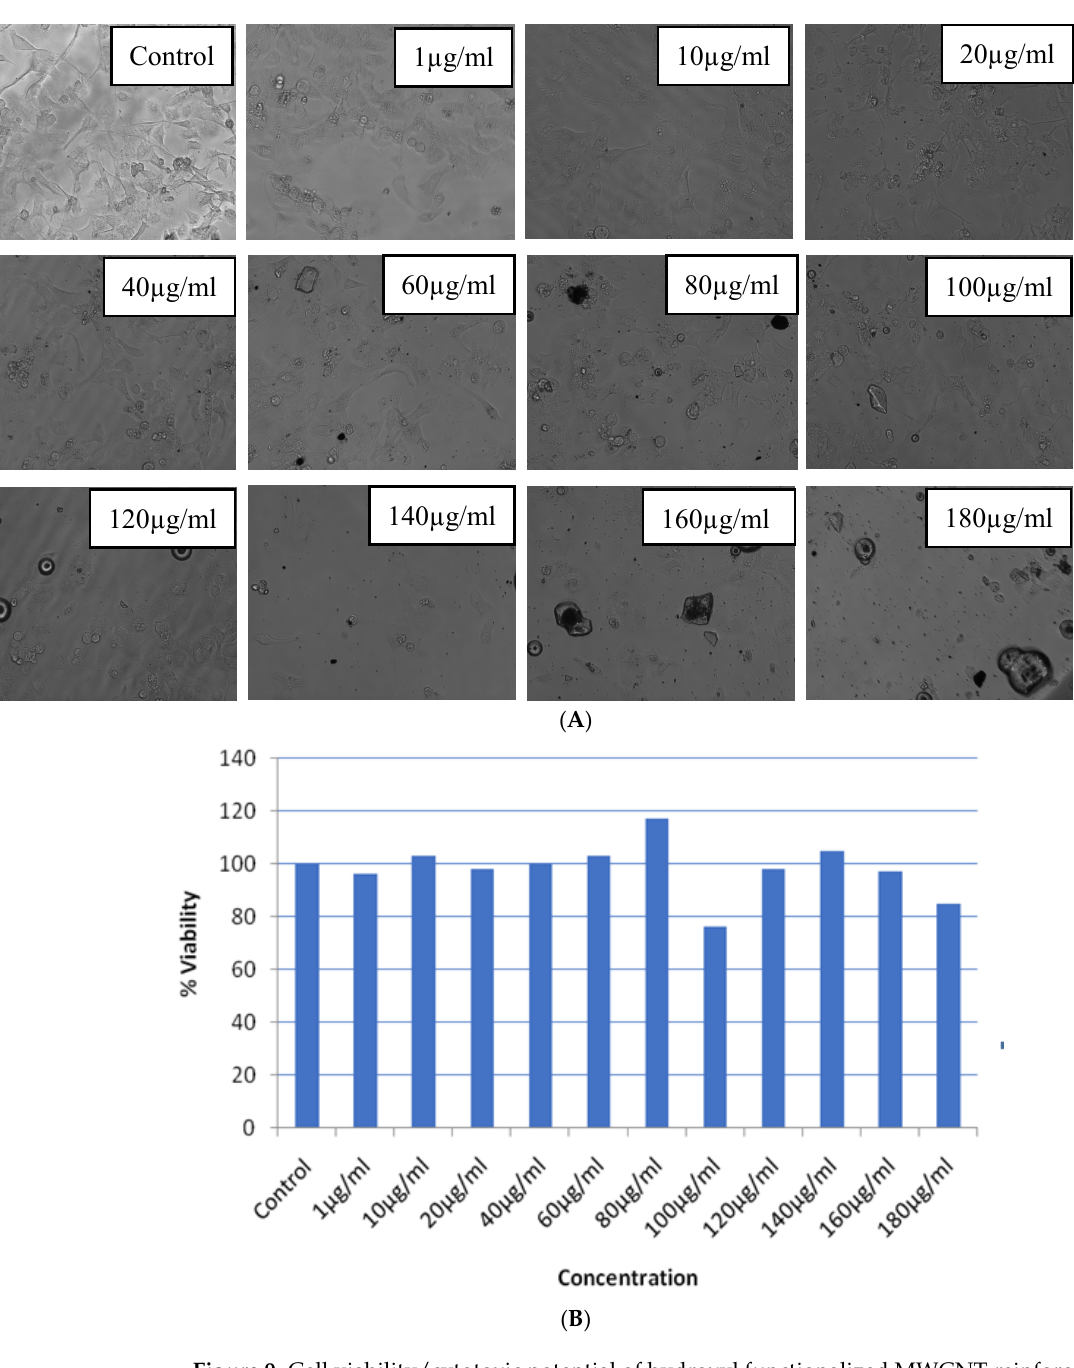
Figure 9. Cell viability/cytotoxic potential of hydroxyl functionalized MWCNT-reinforced PMMA nanocomposites upon 24 h exposure to KB cells in the dose-dependent manner of a concentration range of 1-180 µg/mL ( A ) Microscopic graph ( B ) Cumulative histogram.